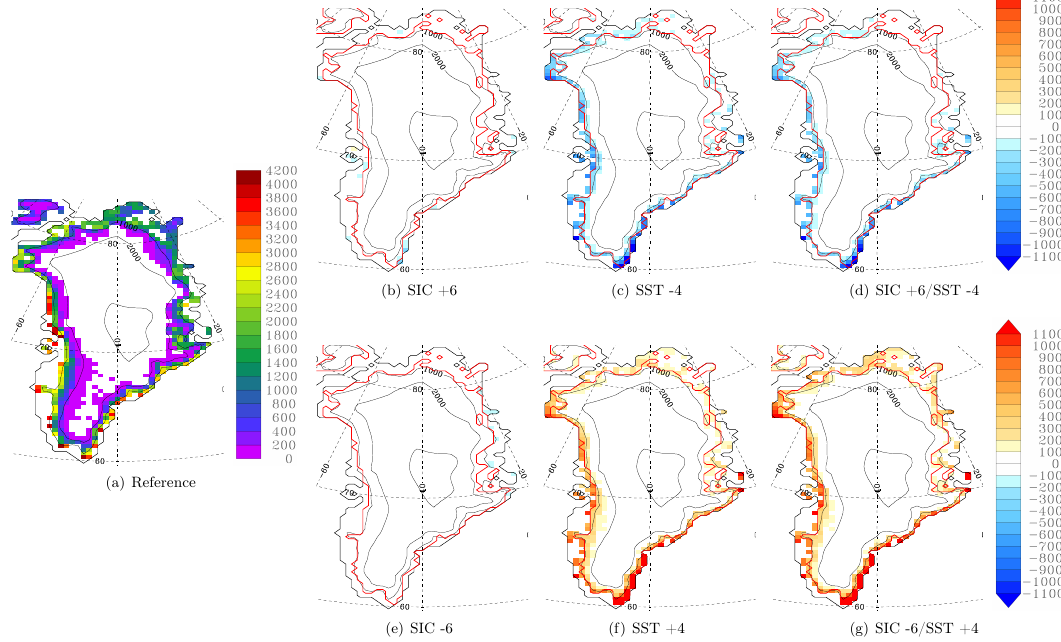
Figure 3. Annual mean cumulated runoff (mmWEyr − 1 ) for the reference run (a) over 2007–2012. Difference in annual mean cumulated runoff (mmWE yr − 1 ) between (b) SIC + 6, (c) SST − 4, (d) SIC + 6/SST − 4, (e) SIC − 6, (f) SST + 4, (g) SIC − 6/SST + 4 experiments and the reference run. The thick red line defines the GrIS area in